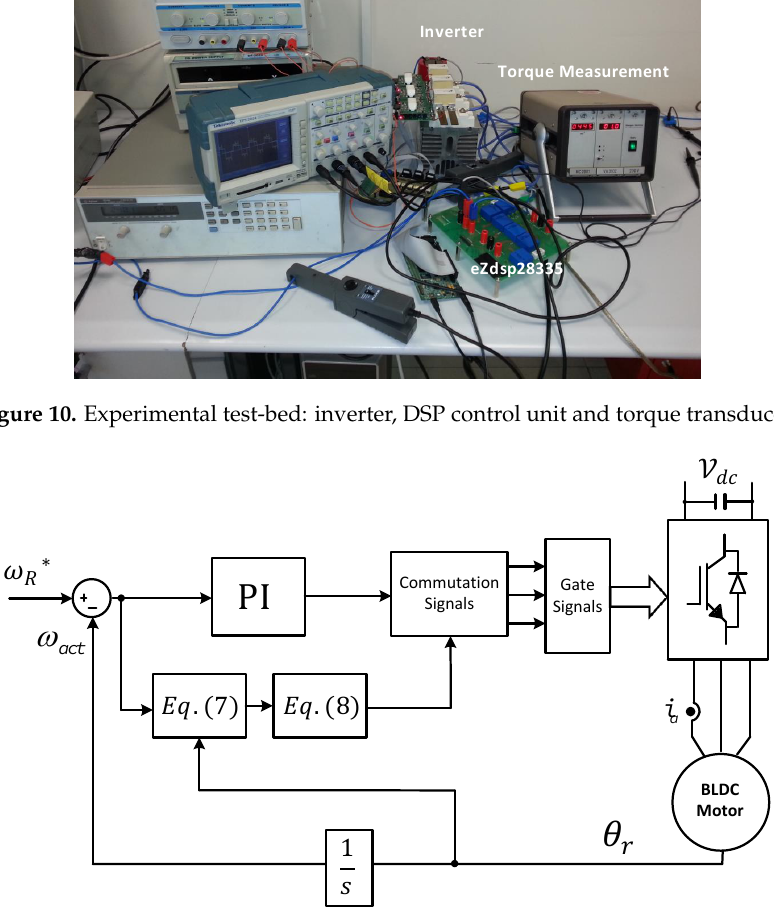
Figure 11. Overall block diagram of the proposed BLDC motor drive in the field weakening